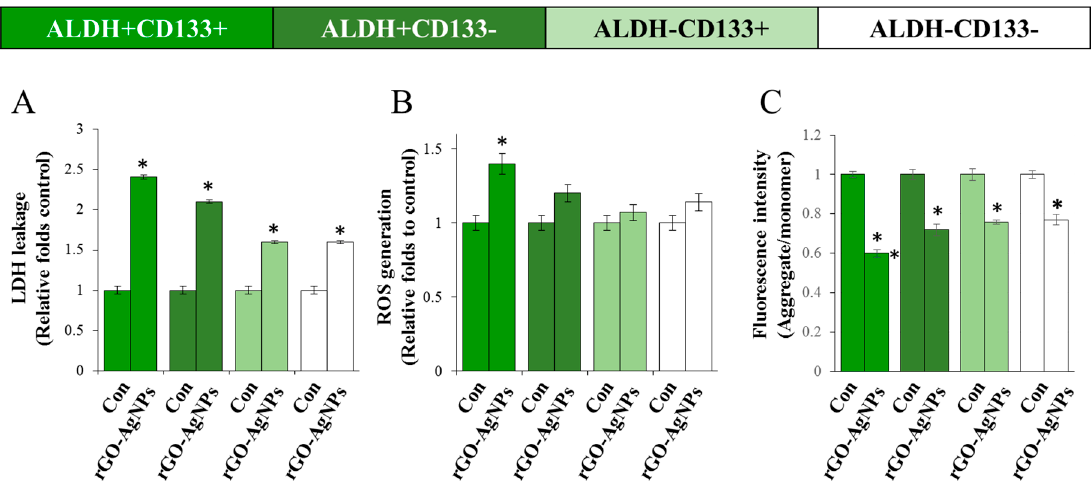
Figure 6. Effect of rGO–Ag on the leakage of LDH, reactive oxygen species (ROS) generation, and mitochondrial membrane potential (MMP) in OvCSCs. Different subpopulations of OvCSCs were incubated with rGO–Ag (2 µg/mL) for 24 h. ( A ) LDH activity was measured at 490 nm using the LDH cytotoxicity kit; ( B ) ROS generation was measured using 2 ′ ,7 ′ -dichlorofluorescein; ( C ) Measurement of MMP in OvCSCs. The results are expressed as the mean ± standard deviation of three independent experiments. The treated groups showed statistically significant differences from the control group according to Student’s t -test (* p < 0.05).